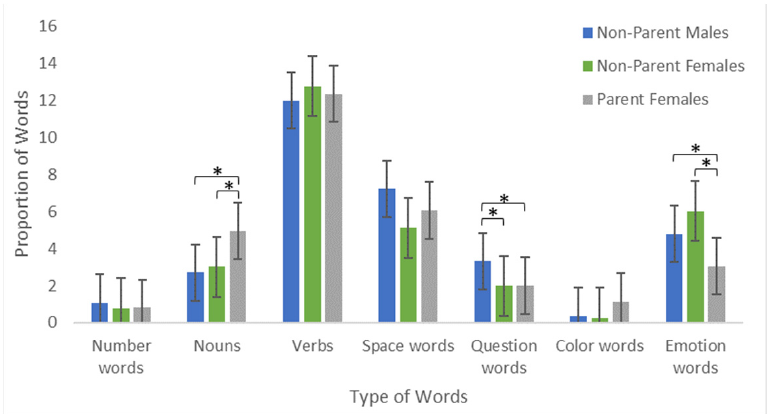
Figure 2. Differences in language quality (i.e., content) between interaction groups. Error bars represent Standard Errors. * p < 0.05.